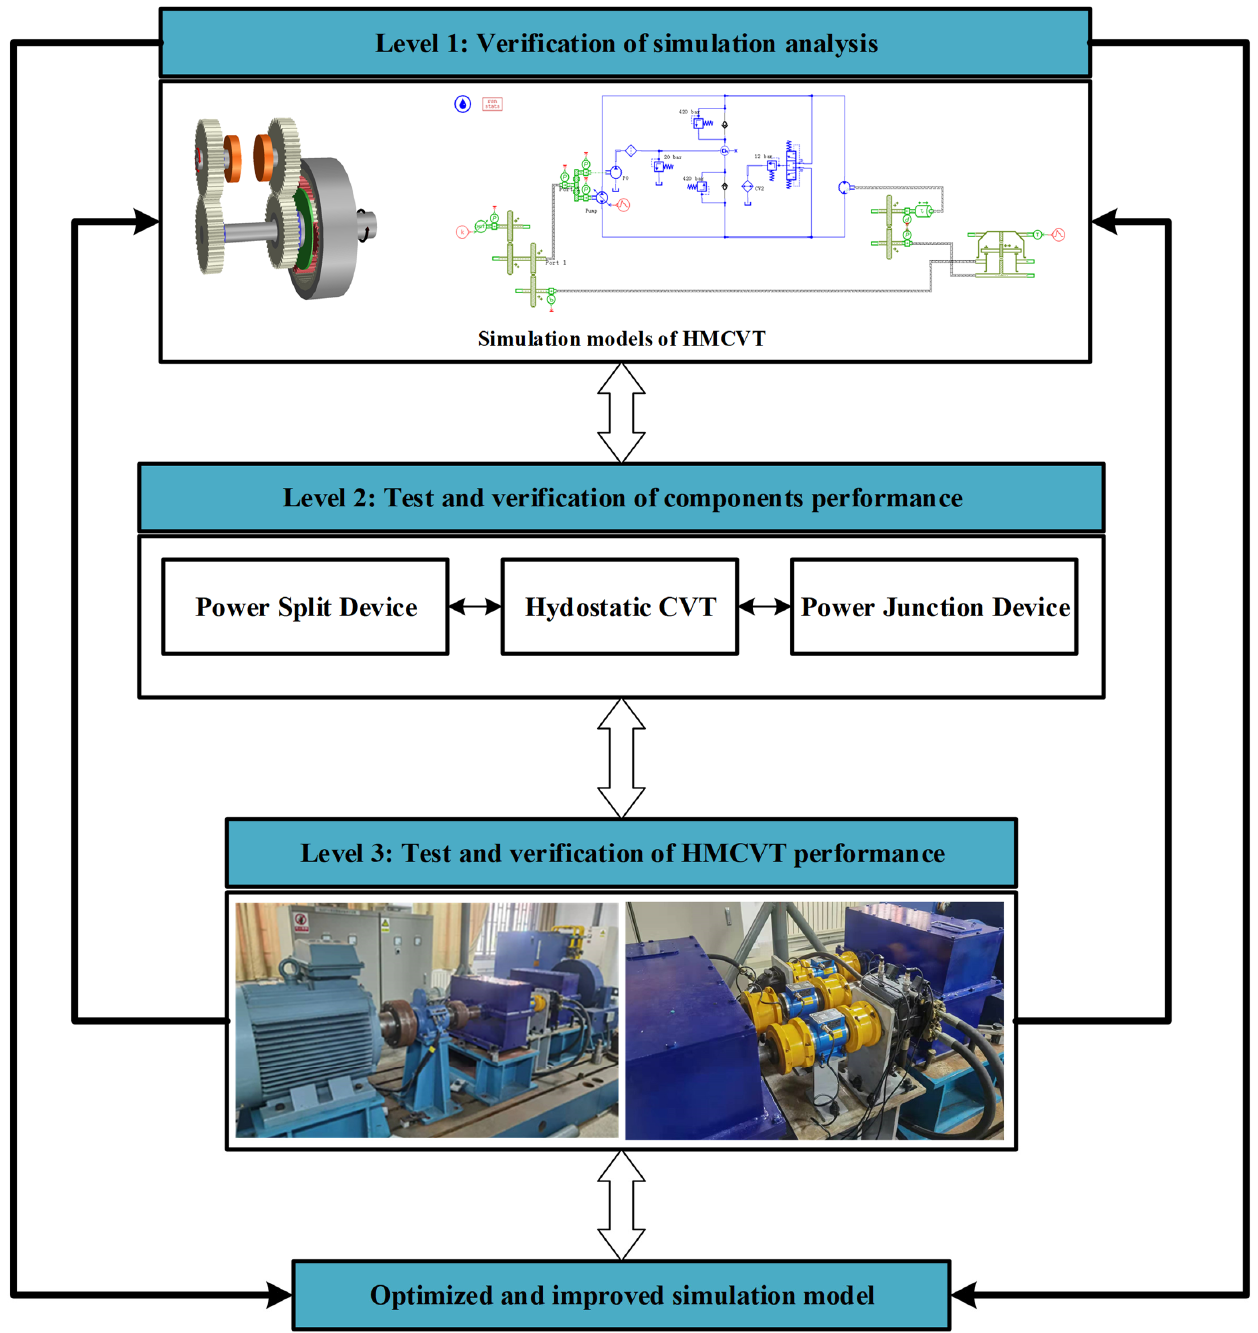
Figure 2. Process of multi-level test and verification.